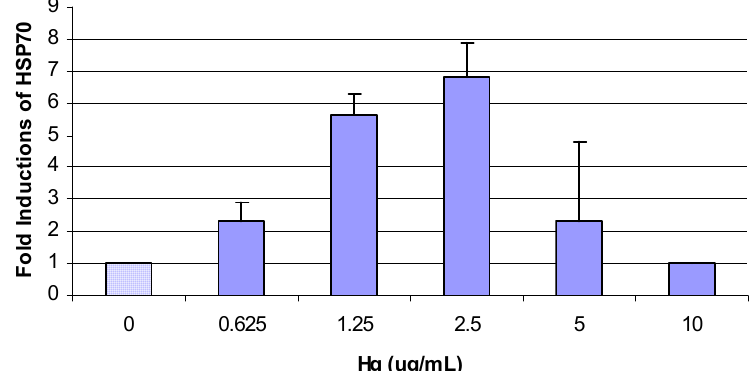
Figure 4. Fold induction of HSP70 in HepG means ± SDs, n = 3.